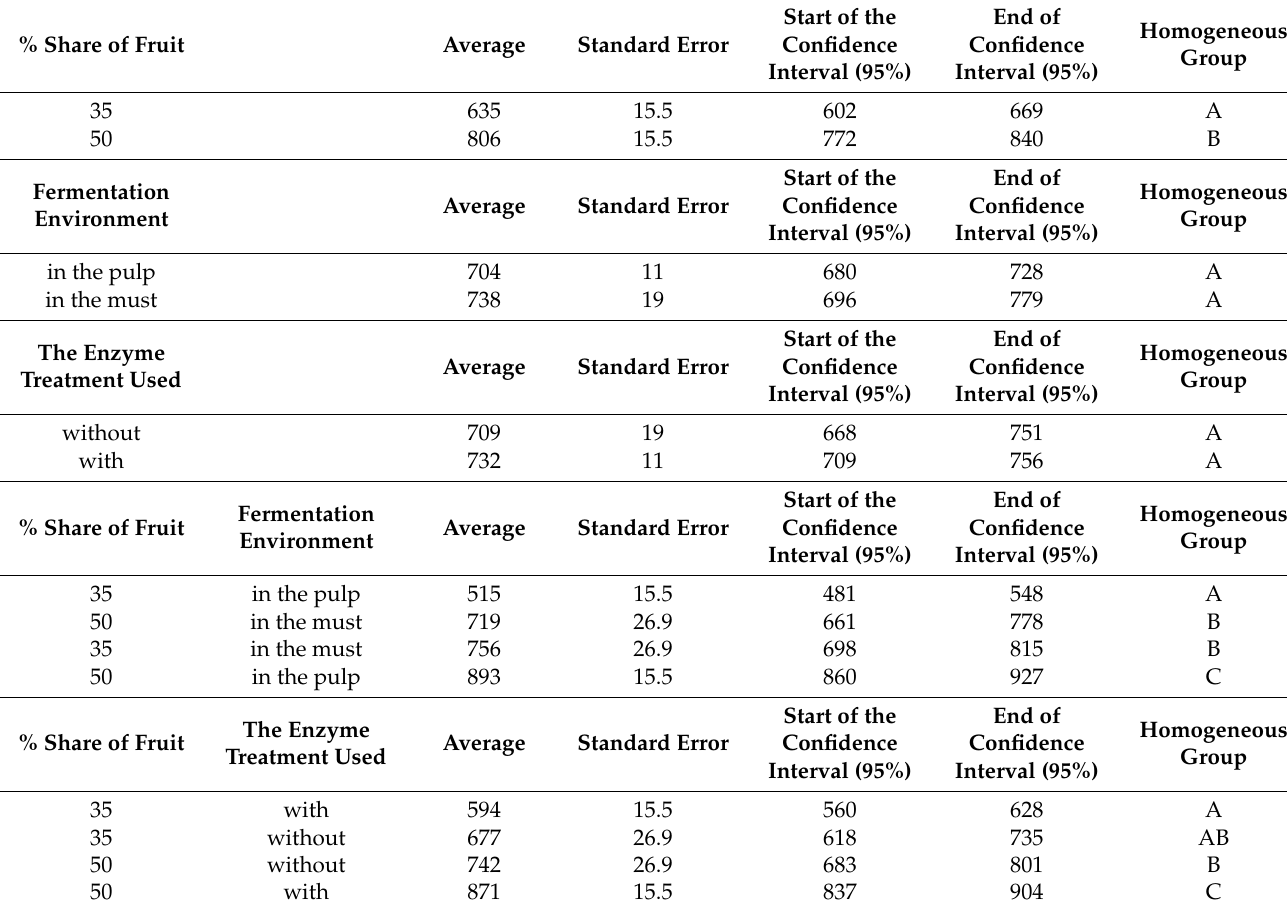
Table 2. Multivariate analysis of variance of the polyphenol content of wines after 3 months of aging on the share of fruit (a), fermentation in must or pulp (b), enzymatic treatment or its absence (c) and a combination of factors a * b and a *